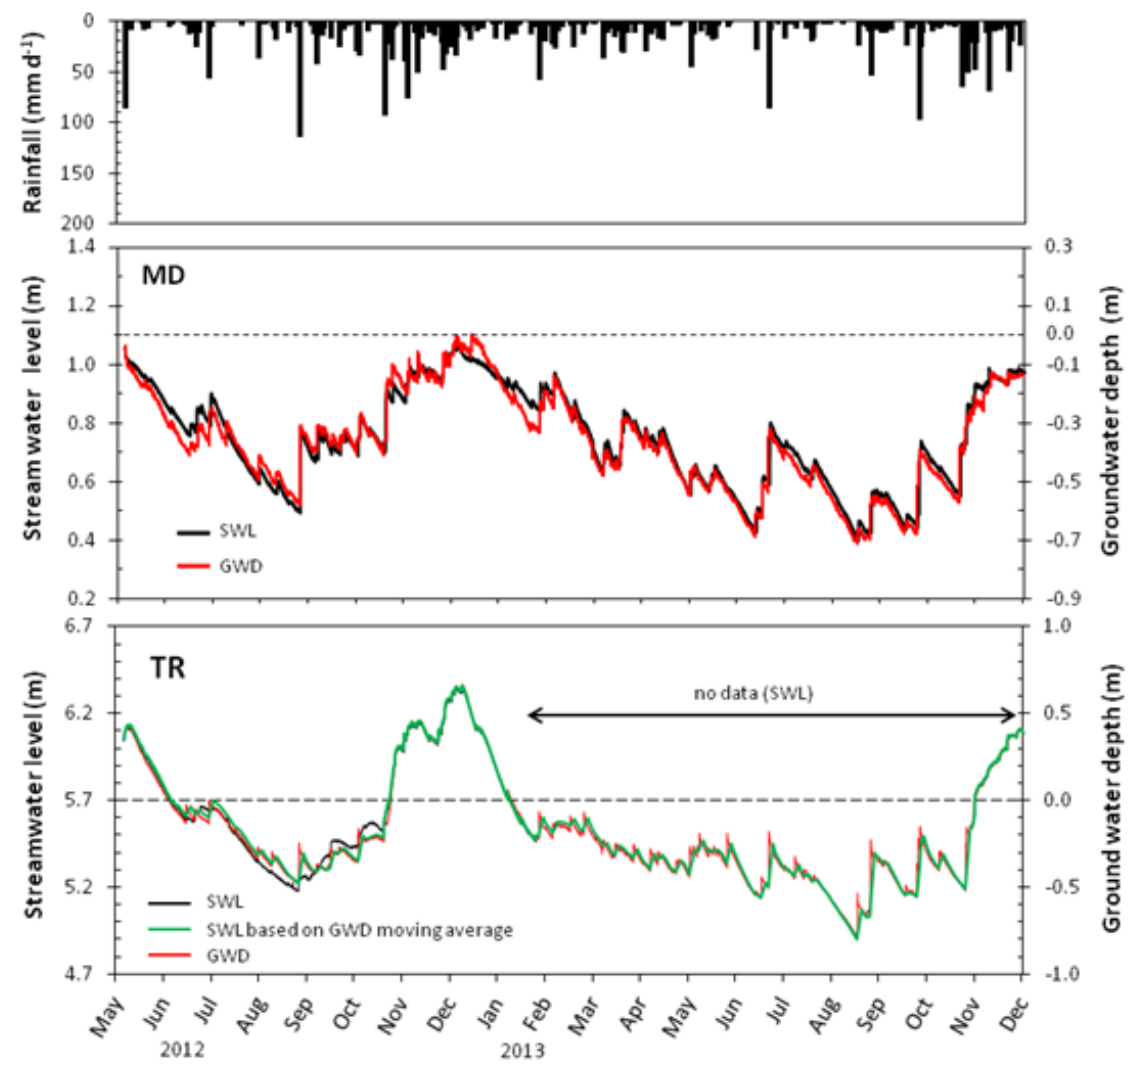
Figure 3. Rainfall (top pane), stream water level (SWL) and groundwater depth (GWD) (middle pane) measured at Meranti Ditch (MD); and SWL and GWD measured at Turip River (TR) together with SWL estimated from moving averages of GWD for that location (bottom